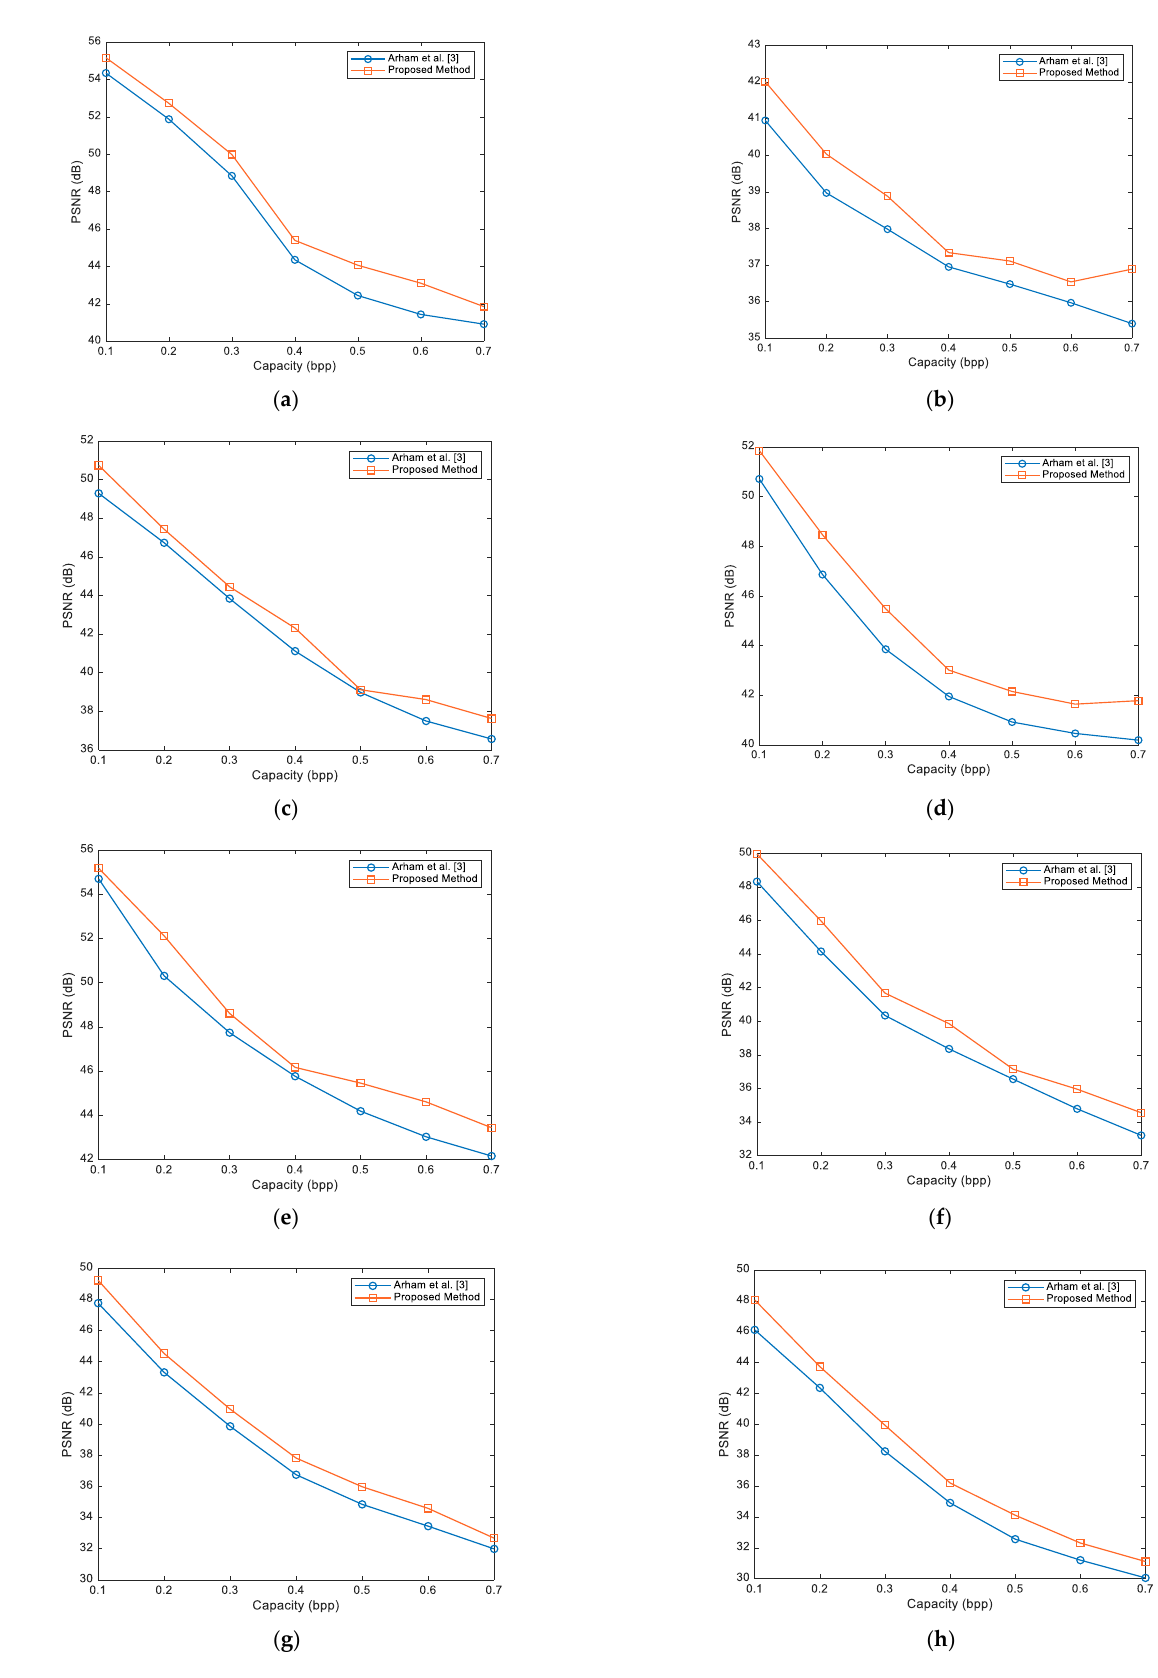
Figure 6. Comparison of image quality for single-layer capacity: ( a ) Airplane; ( b ) Baboon; ( c ) Barbara; ( d ) Ship; ( e ) Lena; ( f ) Peppers; ( g ) Lake; ( h ) Bridge [3]. Moreover, the Baboon image for the capacities of 0.1 bpp, 0.2 bpp, 0.3 bpp, 0.4 bpp, 0.5 bpp, 0.6 bpp, and 0.7 bpp, compared to the method of Arham et al. [3], shows increases in quality of 1.0600 dB, 0.9600 dB, 0.9000 dB, 0.3900 dB, 0.6300 dB, 0.5700 dB and 1.4900 dB, respectively. Meanwhile, the Barbara image for the capacities of 0.1 bpp, 0.2 bpp, 0.3 bpp, 0.4 bpp, 0.5 bpp, 0.6 bpp, and 0.7 bpp increases in quality by 1.4500 dB, 0.7000 dB, 0.610.0 dB, 1.1900 dB, 0.1400 dB, 1.1100 dB, and 1.0600 dB, respectively, compared to the method of Arham et al. [3]. The Ship image for the capacities of 0.1 bpp, 0.2 bpp, 0.3 bpp, 0.4 bpp, 0.5 bpp, 0.6 bpp, and 0.7 bpp increases in quality by 1.1400 dB, 1.6000 dB, 1.6300 dB, 1.0600 dB, 1.2300 dB, 1.1800 dB, and 1.5900 dB, respectively, compared to the method of Arham et al. [3]. The Lena image for capacities of 0.1 bpp, 0.2 bpp, 0.3 bpp, 0.4 bpp, 0.5 bpp, 0.6 bpp and 0.7 bpp, compared to the method of Arham et al. [3], has an increase in quality of 0.4800 dB, 1.8100 dB, 0.8700 dB, 0.4000 dB, 1.2700 dB, 1.5800 dB, and 1.2800 dB, respec- tively. The Peppers image for capacities of 0.1 bpp, 0.2 bpp, 0.3 bpp, 0.4 bpp, 0.5 bpp, 0.6 bpp, and 0.7 bpp, compared to the method of Arham et al. [3], has an increase in quality of 1.6500 dB, 1.8200 dB, 1.3300 dB, 1.50 dB, 0.5900 dB, 1.1700 dB, and 1.3500 dB, respec- tively. The Lake image for the capacities of 0.1 bpp, 0.2 bpp, 0.3 bpp, 0.4 bpp, 0.5 bpp, 0.6 bpp, and 0.7 bpp increases in quality by 1.4700 dB, 1.2100 dB, 1.1000 dB, 1.0700 dB, 1.1300 dB, 1.1400 dB, and 0.6900 dB, respectively, compared to the method of Arham et al. [3]. The Cameraman image for capacities of 0.1 bpp, 0.2 bpp, 0.3 bpp, 0.4 bpp, 0.5 bpp, 0.6 bpp and 0.7 bpp, compared to the method of Arham et al. [3], has an increase in quality of 1.9400 dB, 1.3800 dB, 1.6900 dB, 1.2900 dB, 1.5500 dB, 1.1100 dB, and 1.0600 dB, respec- tively. The Bridge image for capacities of 0.1 bpp, 0.2 bpp, 0.3 bpp, 0.4 bpp, 0.5 bpp, 0.6 bpp, and 0.7 bpp, compared to the method of Arham et al. [3], has an increase in quality of 1.4500 dB, 1.8200 dB, 0.9600 dB, 1.2400 dB, 1.5000 dB, 0.8400 dB, and 1.0600 dB, respec- tively. The proposed method has more insertion capacity than that of Arham et al. [3] for the first and higher insertion layers. Table 5 shows the PSNR comparison of the proposed method and the method of Arham et al. [3] for the eight insertion layers. As the number of insertion layers increases, the total insertion capacity increases. As shown in Table 5, the values of insertion capacity and PSNR for the proposed method are higher than those in the method of Arham et al. [3]. According to Table 5, the average insertion capacity increase in the eight insertion layers in the proposed method is 0.625 bpp, and in the method of Arham et al. [3] it is 0.572 bpp. In insertion layer eight, the Peppers, Lena, Bar- bara, and Baboon images have the highest increase in capacity, while the Airplane, Ship, Lake, Bridge, and Cameraman images have the slightest increase in capacity, compared to the method of Arham et al. [3].